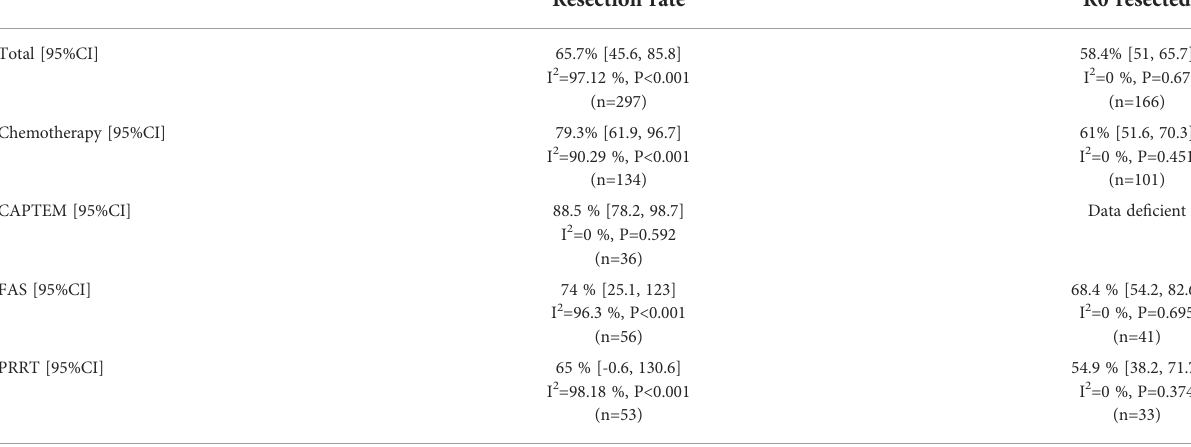
TABLE 3 Estimate of surgical resection rate and R0 resection rate after neoadjuvant therapy between different therapy regimens. Resection